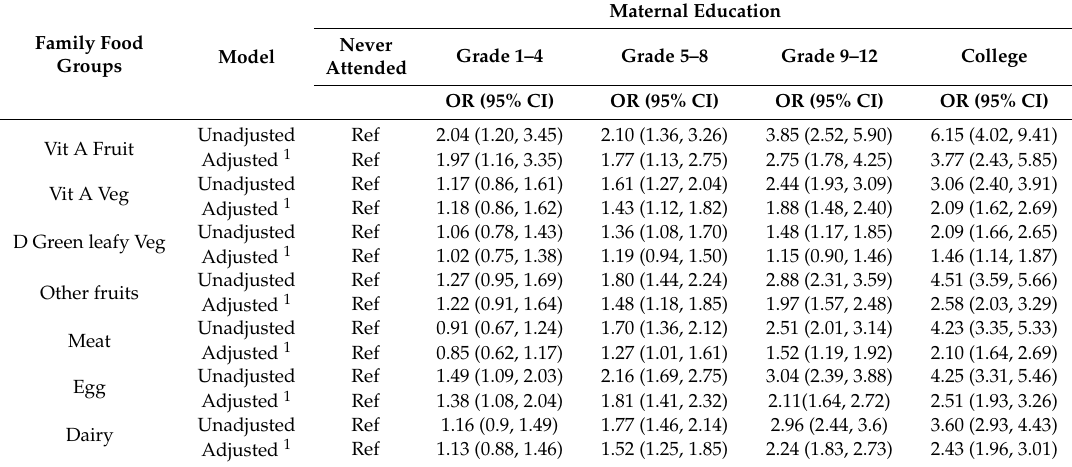
Table 6. Family food consumption and its association with Maternal Education, Addis Ababa, Ethiopia.